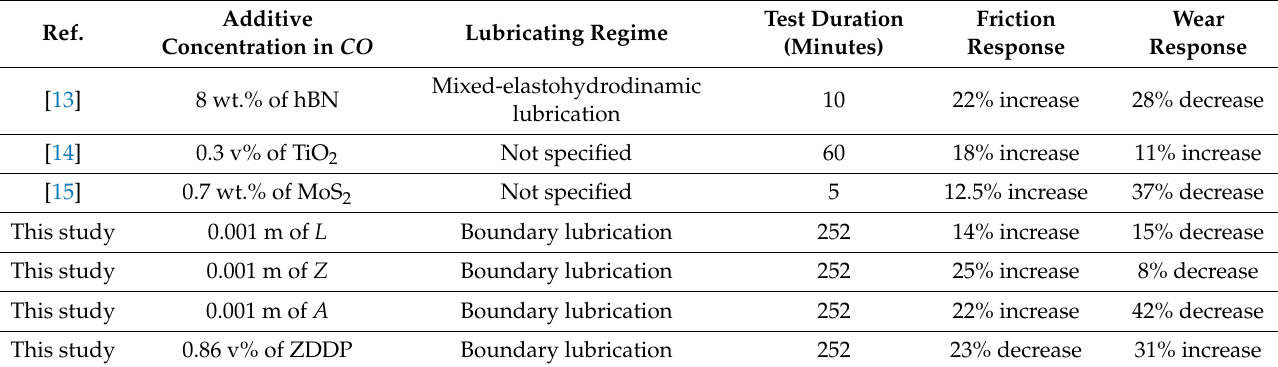
Table 3. The difference in friction and wear response of castor oil with additives compared to the same oil deprived of them.